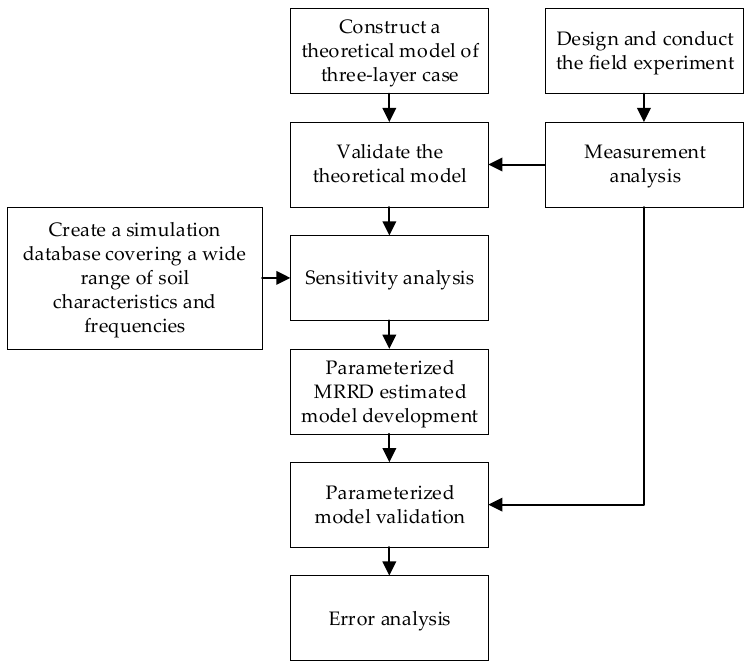
Figure 2. The flow chart of the parameterized model development and validation process.